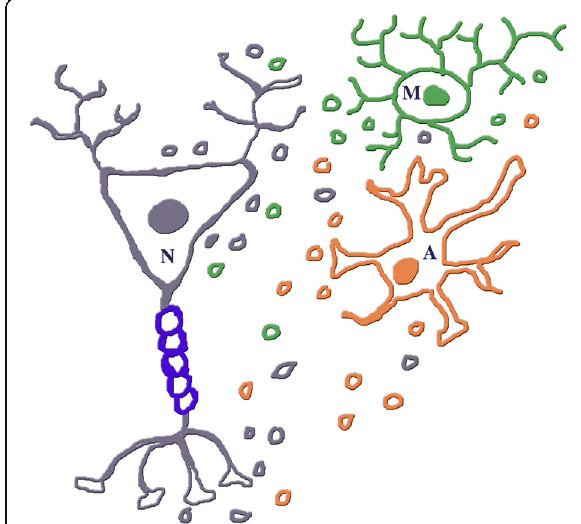
Fig. 4 The three types of brain cells, neurons (N), astrocytes (A) and microglia (M), together with EVs they have secreted. For each parental cell and its EVs the color is the same: black for the neuron, orange for the astrocyte, green for the microglia. The blue ring sequence covering the neuronal axon is due to a myelin sheath. The EVs are distributed in the extracelluar space. Some of them are distributed close to their cell of origin, possibly because they have been secreted recently. The EV mixture of the three colors in the space among the cells may be due to vesicles addressed to specific targets, cells and fluids (CSF, blood serum, not